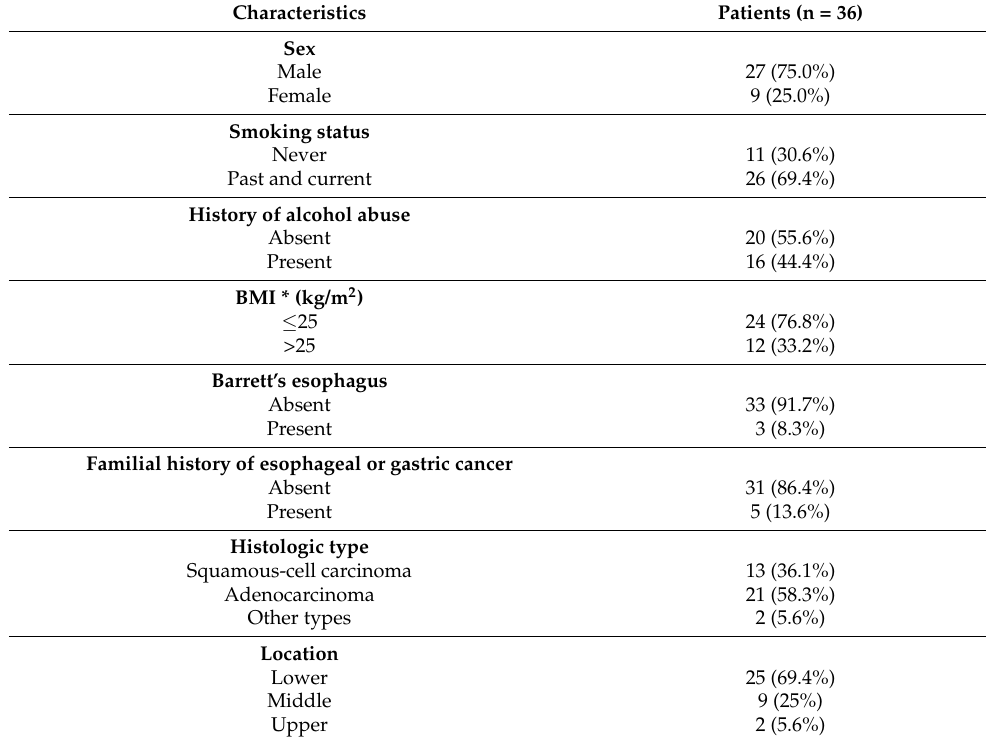
Table 1. Demographics, life habits, and cancer